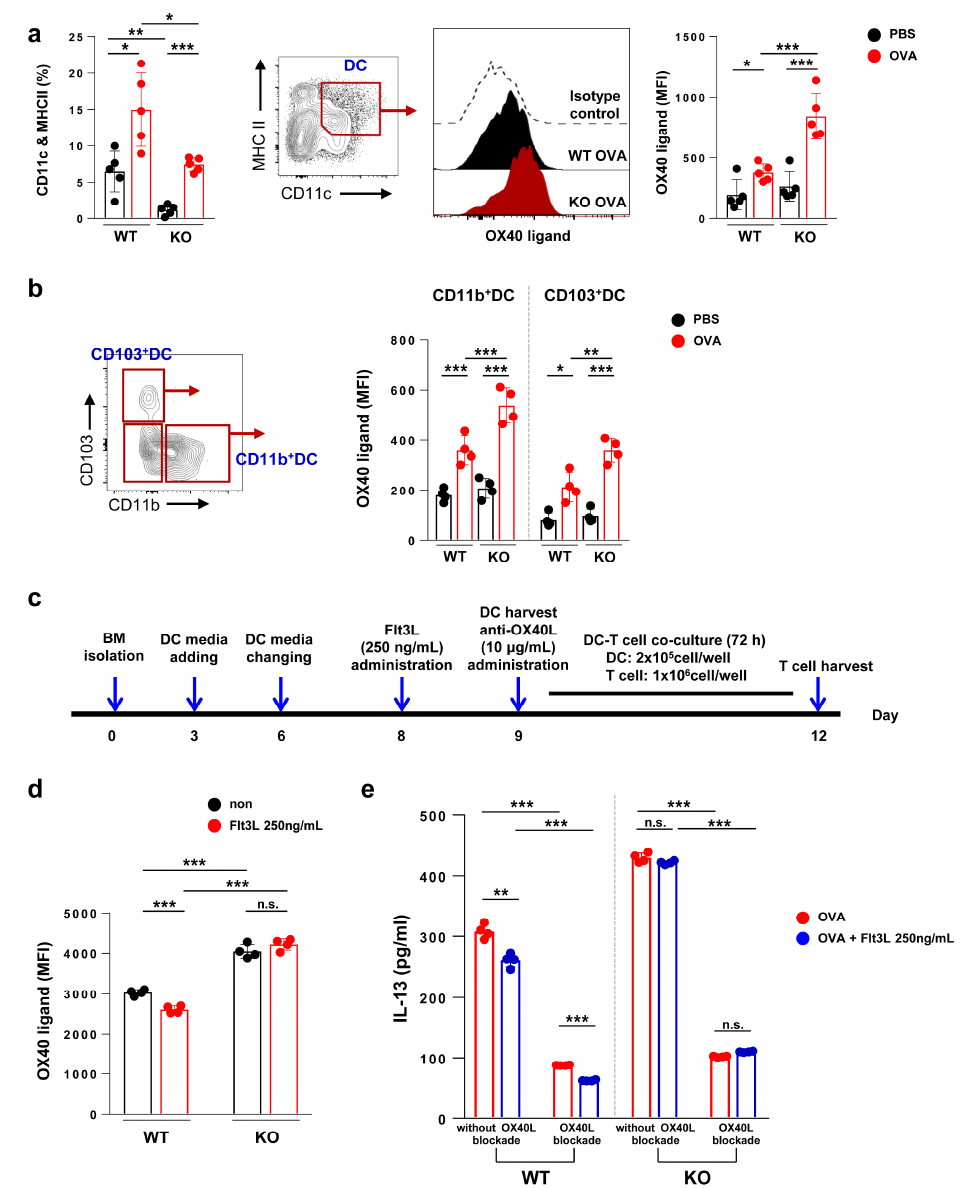
Figure 7. Expression of OX40 ligand (OX40L) in dendritic cells (DCs) from wild-type (WT) and Figure 7 Flt3 knockout (KO) mice. ( a ) Comparison of CD11c and MHC II double-positive cells (left panel). Gating strategy for investigating the OX40L level in lung DCs (center panel) and comparison of OX40L expression in ovalbumin (OVA)-treated WT and Flt3 KO mice (right panel). ( b ) Gating strategy for investigating CD11b + DCs and CD103 + DCs (left panel). Comparison of OX40L expression in CD11b + DCs and CD103 + DCs of OVA-treated WT and Flt3 KO mice (right panel). ( c ) Schematic protocol for the generation of bone marrow-derived dendritic cells (BMDCs) and their co-culture with CD4 + T cells from the spleens of OVA-specific OT-II Tg mice. Some cultures were supplemented with the Flt3 ligand (Flt3L; 250 ng / mL) or anti-OX40L (10 µ g / mL). ( d ) Comparison of OX40L expression following Flt3L administration in BMDCs derived from WT and Flt3 KO mice. ( e ) Comparison of the IL-13 level in CD4 + T cells cultured with OVA-treated BMDCs from WT and Flt3KO mice following OX40L blockade and Flt3L administration. Data are representative of three independent experiments with